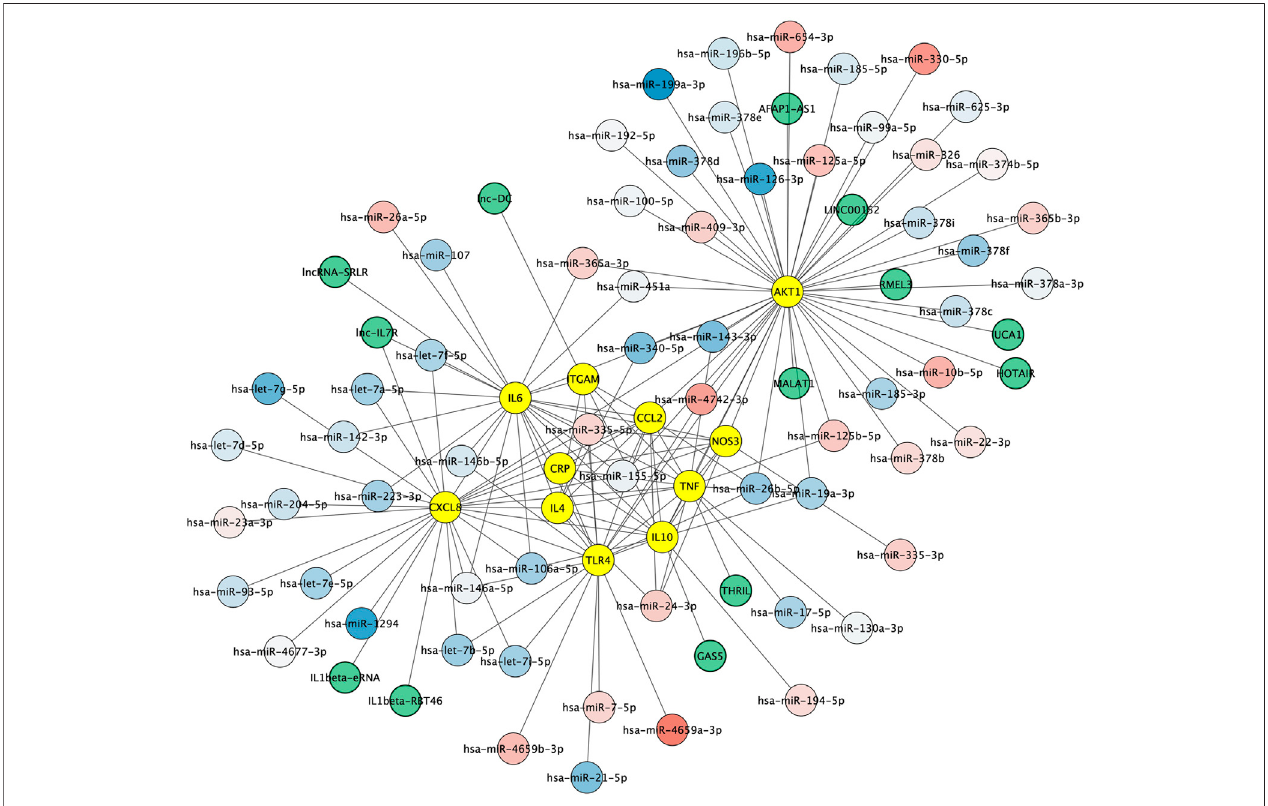
FIGURE 5 | Non-coding RNA-protein interaction network. Experimentally validated interactions between microRNAs dysregulated in Alzheimer (blue to red round shapes), lncRNAs (green round shapes) and key proteins in Alzheimer ’ s disease neuroin fl ammation (yellow round shapes). Blue to red gradient denotes low to high relative abundance of microRNAs in Alzheimer ’ s disease patient samples according to (Leidinger et al., 2013).